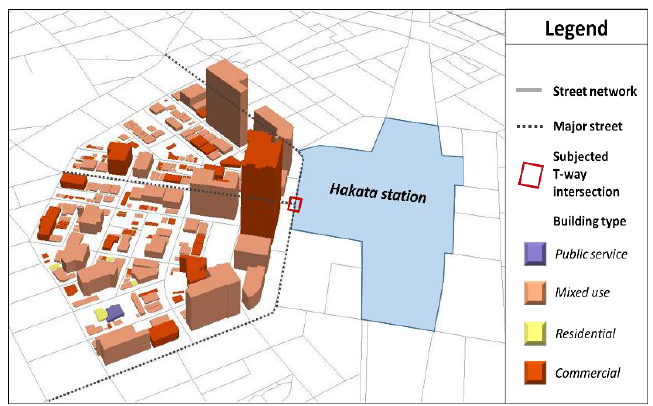
Figure 2. Land use map of study area with the volume of